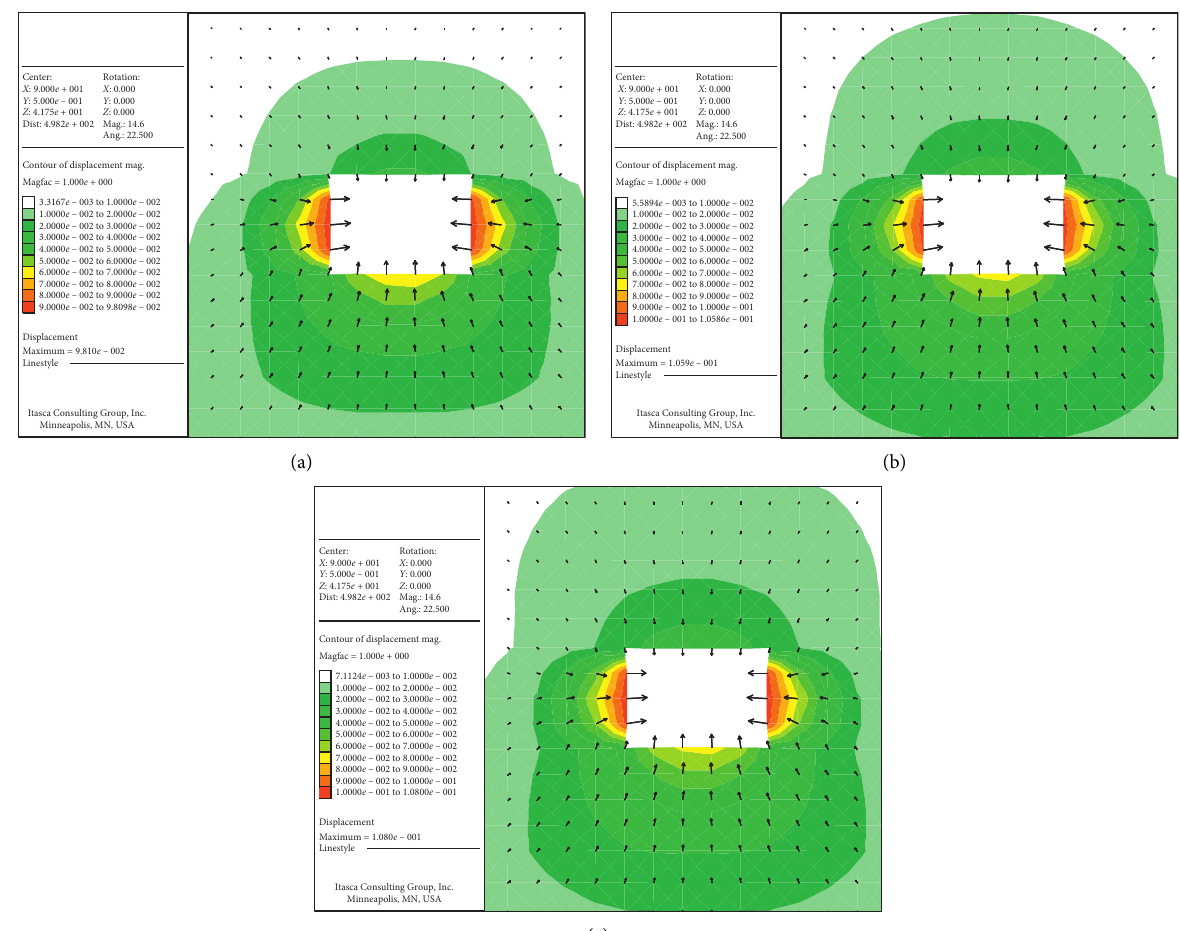
Figure 11: Cloud diagram of displacement. (a) 300 step; (b) 600 step; and (c) 2100 step.